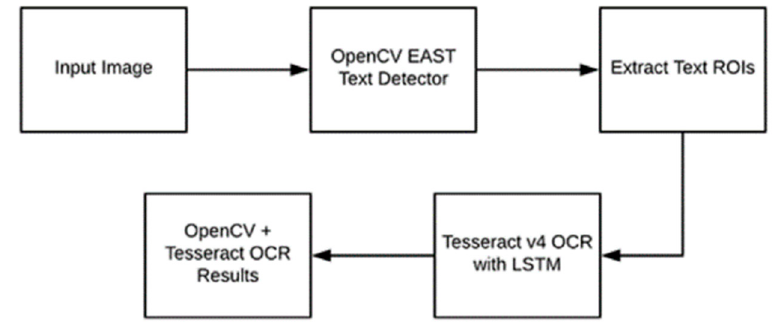
Figure 8. OpenCV OCR flow chart.